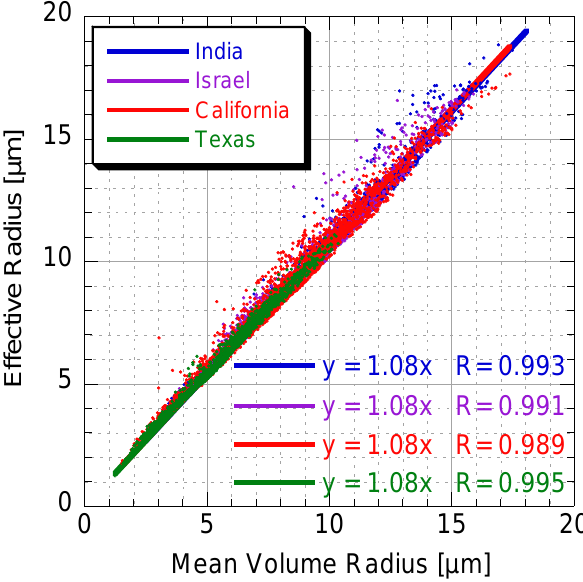
Fig. 4. The cloud drop concentration, N d , and effective radius, r e , at a horizontal cross section through a convective tower. Note the relative stability of r e up to the cloud edge while N d is highly vari- able. This is a manifestation of the nearly inhomogeneous mixing that dilutes N d while keeping r e nearly constant.